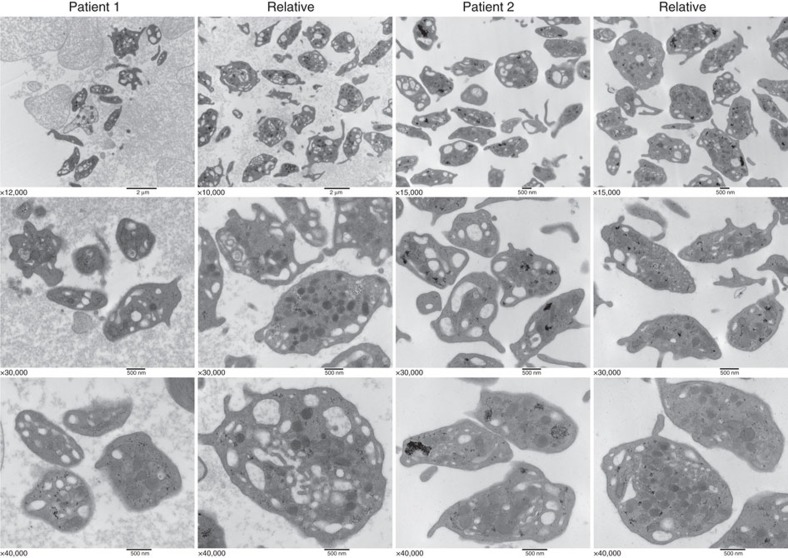
Transmission electron microscopy of platelets from ARPC1B-deficient patients and normal relatives.Electron micrographs of fixed platelet sections taken at magnifications ranging from × 10,000 to × 40,000 (magnification on each panel; bars=500 nm, top left two panel bars=2 μm) indicate the presence of generally small and morphologically variable platelets in patient samples (see also Fig. 3). Dense granules were evaluated by whole mount transmission electron microscopy (Fig. 5b,c).